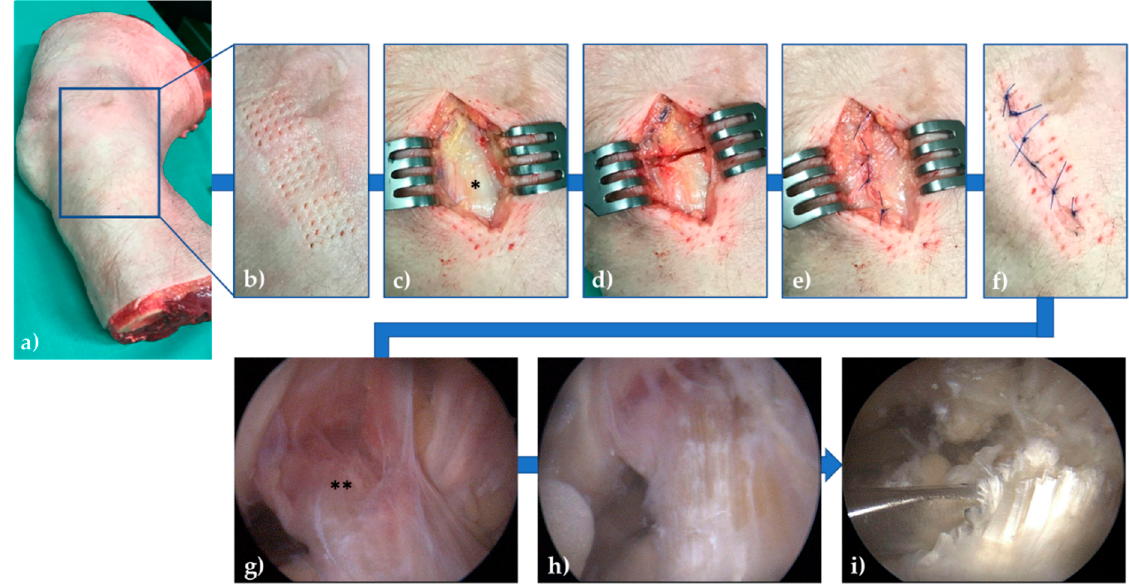
Figure 2. Graded knee joint ligament injuries via surgical ( b – f ) and arthroscopic ( g – i ) approaches. After identification of the medial joint line ( a ), the superficial medial collateral ligament (sMCL) was repetitiously stitched ( n = 75 stitches) above, below, and at the level of the joint line ( b ). Then, via a longitudinal incision, the skin, subcutaneous tissue, and fascia were cut and retracted to expose the sMCL (*, c ), which was completely transected at the femoral portion ( d ). Layer-wise closure of the superficial fascia ( e ) and the subcutaneous tissue and skin ( f ) was performed. Arthroscopically, the anterior cruciate ligament (ACL) was identified (**) ( g ), synovectomized ( h ), and completely transected at mid-substance level ( i ).